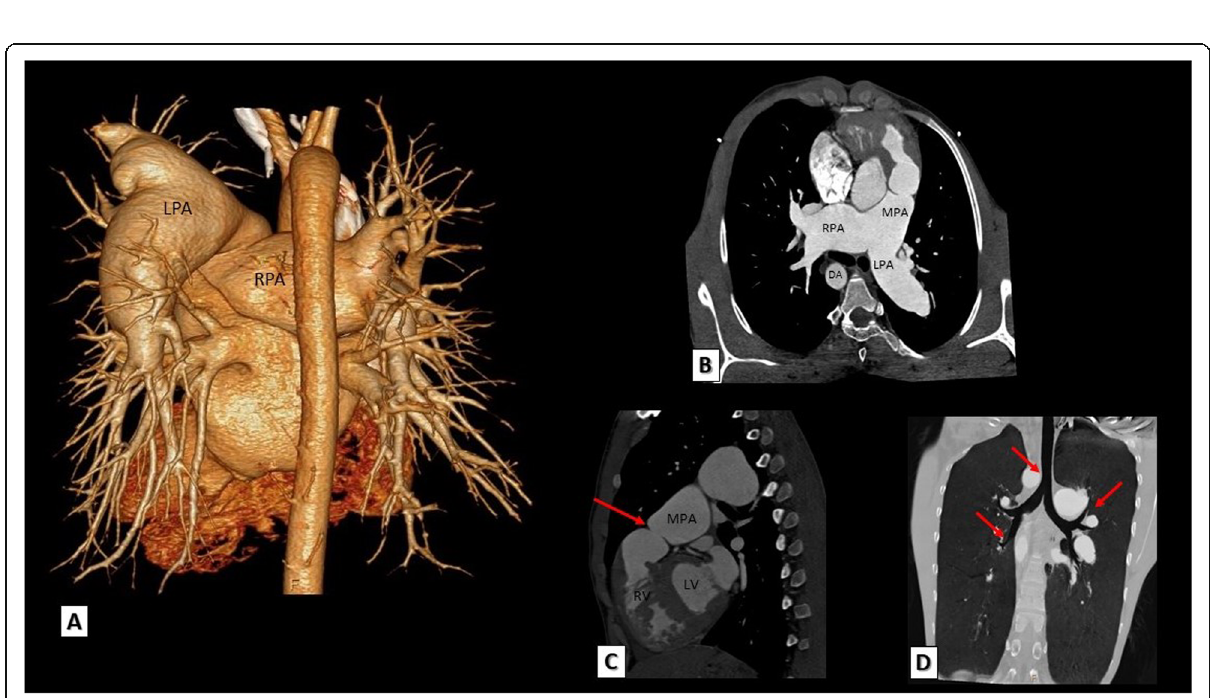
Fig. 7 A case of TOF with absent pulmonary valve. a 3D VRT and b reformatted axial MDCT images showing hugely dilated pulmonary arteries. Note the associated right sided aortic arch. c A reconstructed sagittal MDCT image showing absent pulmonary valve (red arrow) and RVOT obstruction. d A reconstructed coronal MDCT MIP image showing mild compression on trachea and airway (red arrows). RPA, right pulmonary artery; LPA, left pulmonary artery; MPA, main pulmonary artery; DA, descending aorta; LV, left ventricle; RV, right ventricle